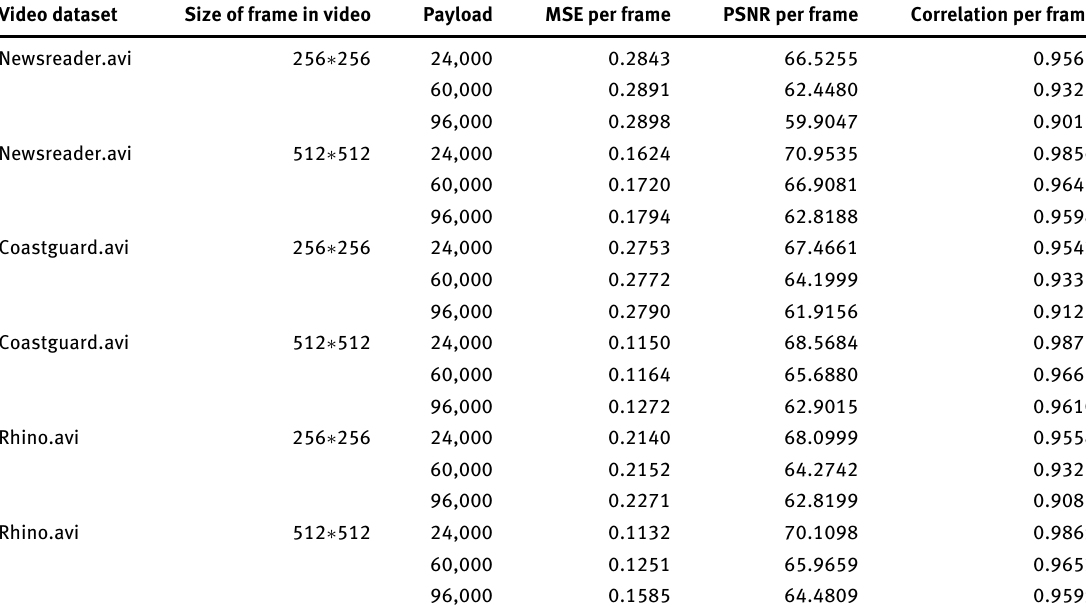
Table 1: The Experimental Results of the Proposed